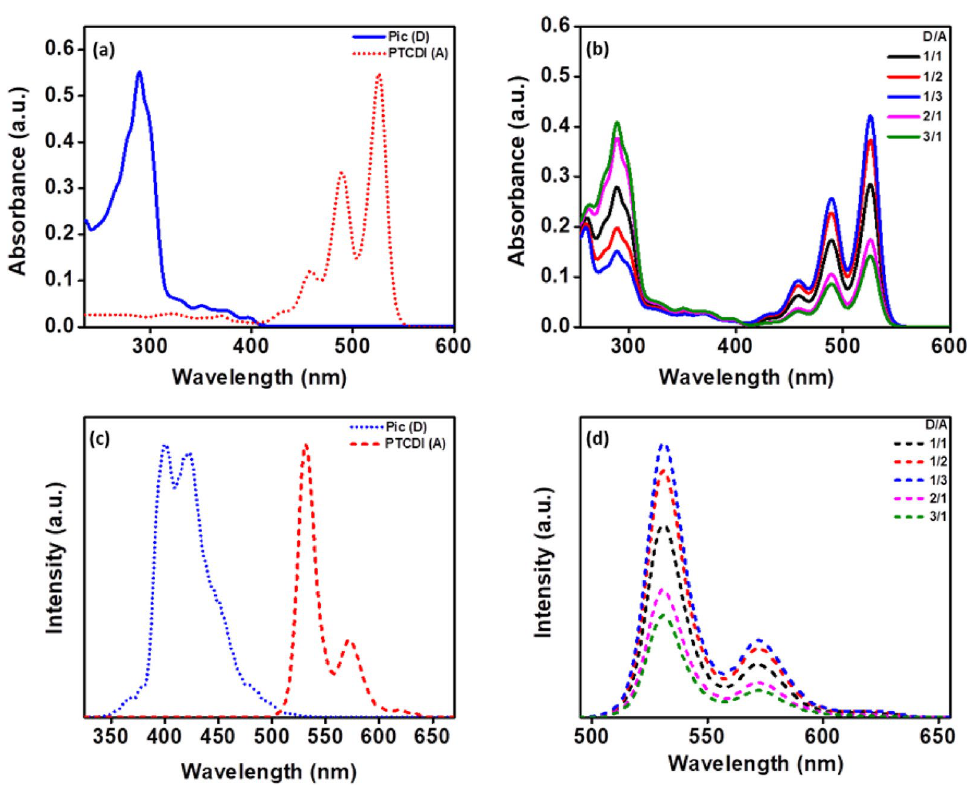
Figure 2. Absorption ( a , b ) and emission ( c , d ) spectra of D, A and D/A blends. Graphs were plotted using Origin software (https ://www.origi nlab.com/, version: